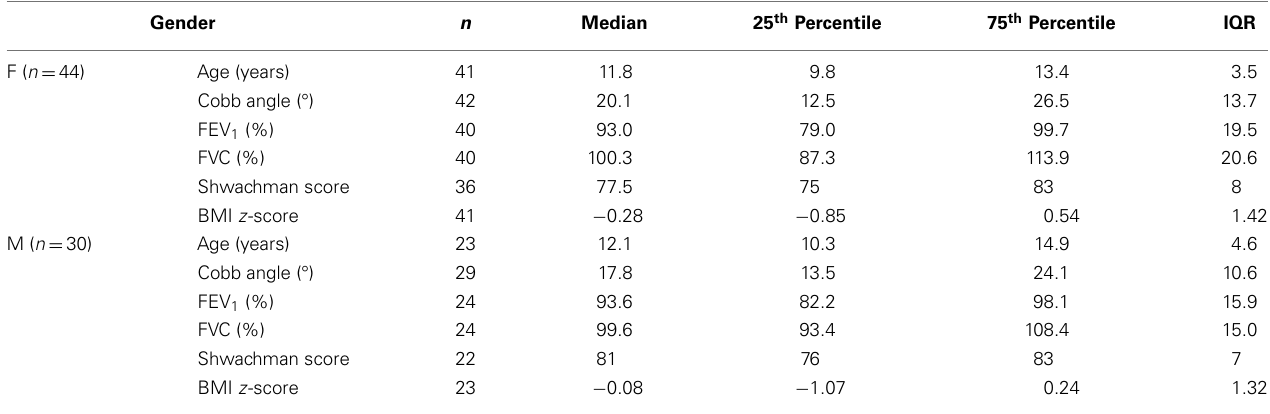
Table 2 | Comparison of prevalence of abnormal thoracic kyphosis . Upper limits for normal thoracic kyphosis